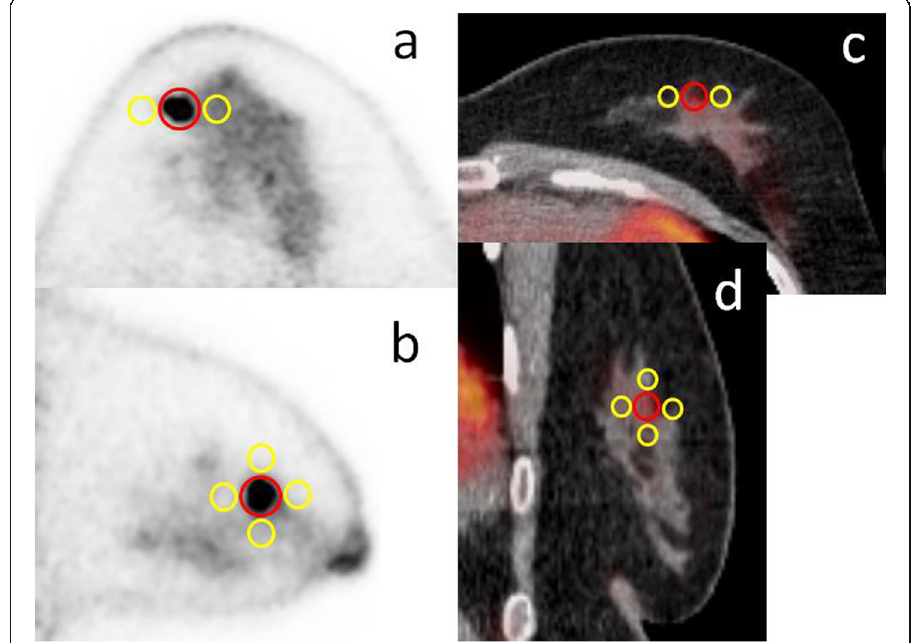
Fig. 2 Positioning of the volume of interest (VOI) for the measurement of clinical PET images. A spherical VOI (red) on FDG uptake of the tumour and 5 (or 6) spherical VOIs (yellow) were placed to calculate the TBR. Transaxial and sagittal images of dbPET ( a , b ) and whole-body PET/CT ( c , d